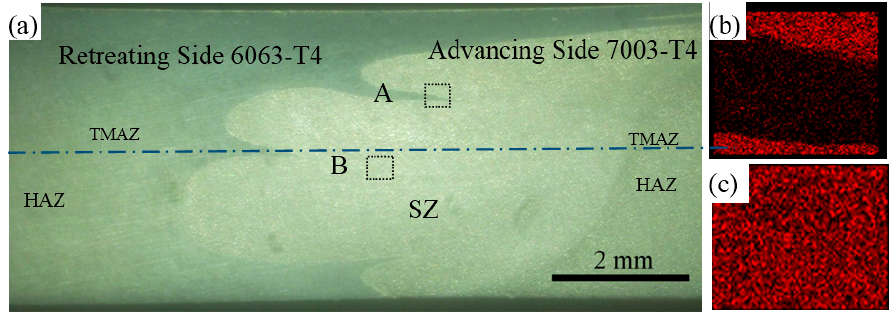
Figure 3. ( a ) Macrostructure of dissimilar FSW joint; EDS map of element Zn distribution in location of ( b ) A and ( c ) B.